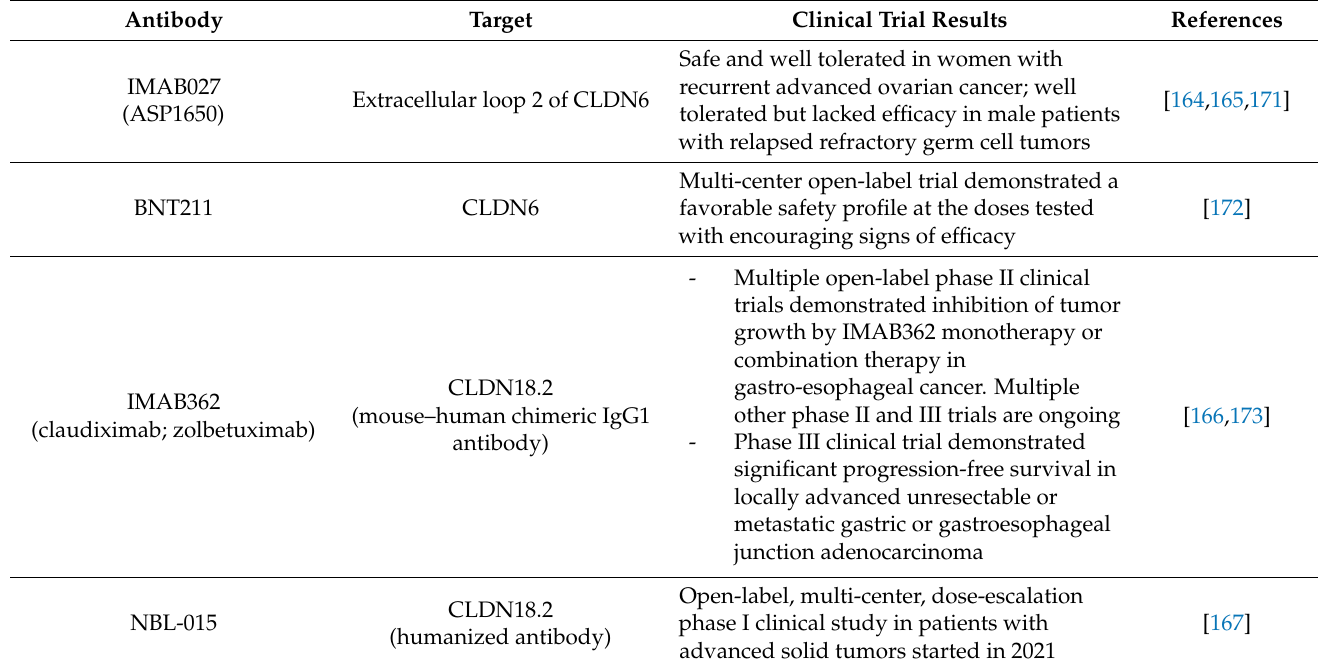
Table 1. Anti-CLDN antibodies and their therapeutic effects in clinical